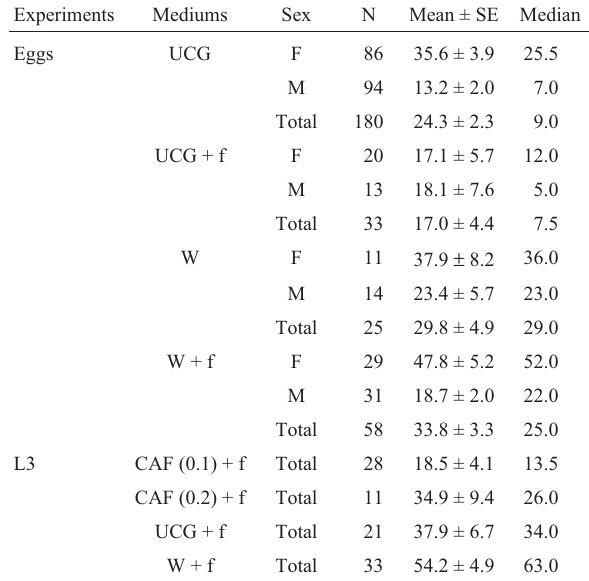
Table 4 - Descriptive statistics for longevity data of adults from experiments using eggs, with and without addition of food (f), developed in mediums with used coffee grounds (UCG) at 25 mg/mL and water (W), and from experiments using L3 larvae plus food, developed in mediums with caffeine (CAF) at 0.1 and 0.2 mg/mL, UCG at 25 mg/mL and water. F = females; M = males; N= number of